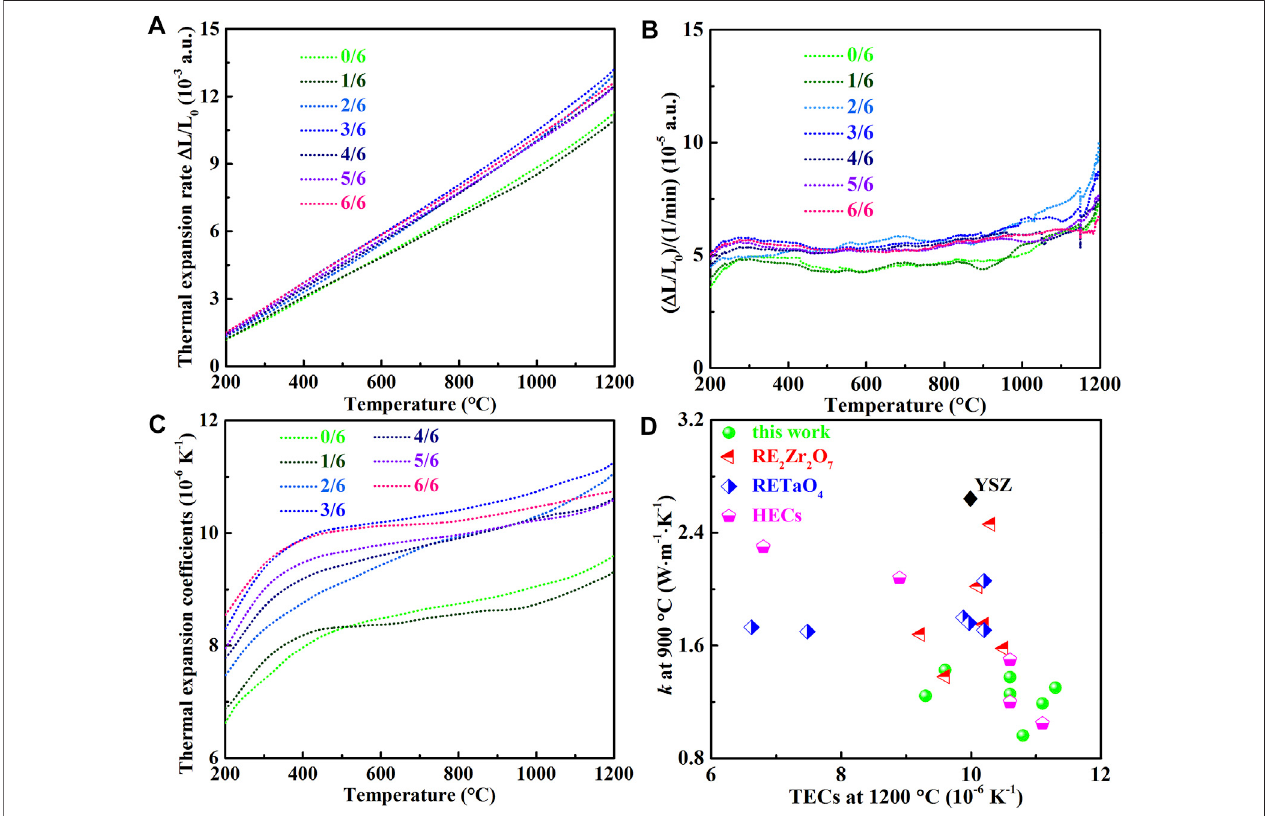
FIGURE 6 | Thermal properties of (La 1-x Ho x ) 3 NbO 7 ( x (cid:2) 0/6, 1/6, 2/6, 3/6, 4/6, 5/6, and 6/6) ceramics: (A) thermal expansion rate, (B) fi rst-order differential curve, (C) thermal expansion coef fi cients; and (D) comparison ofthermal conductivityand TECs among various oxide TBCs (Vassen et al., 2000;Schlichtinget al.,